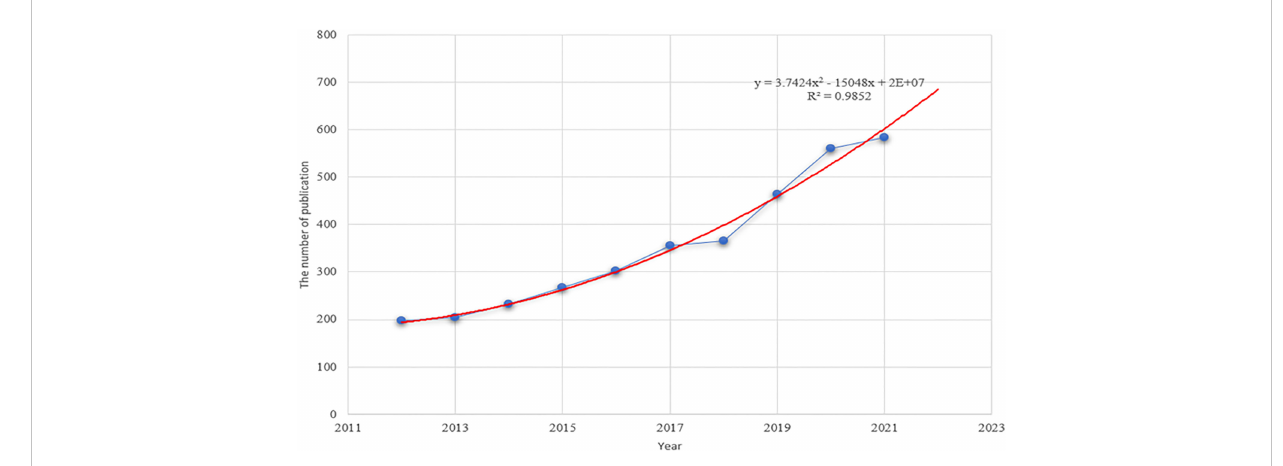
FIGURE 1 The polynomial curve fi tting of publication growth in tumor ablation and